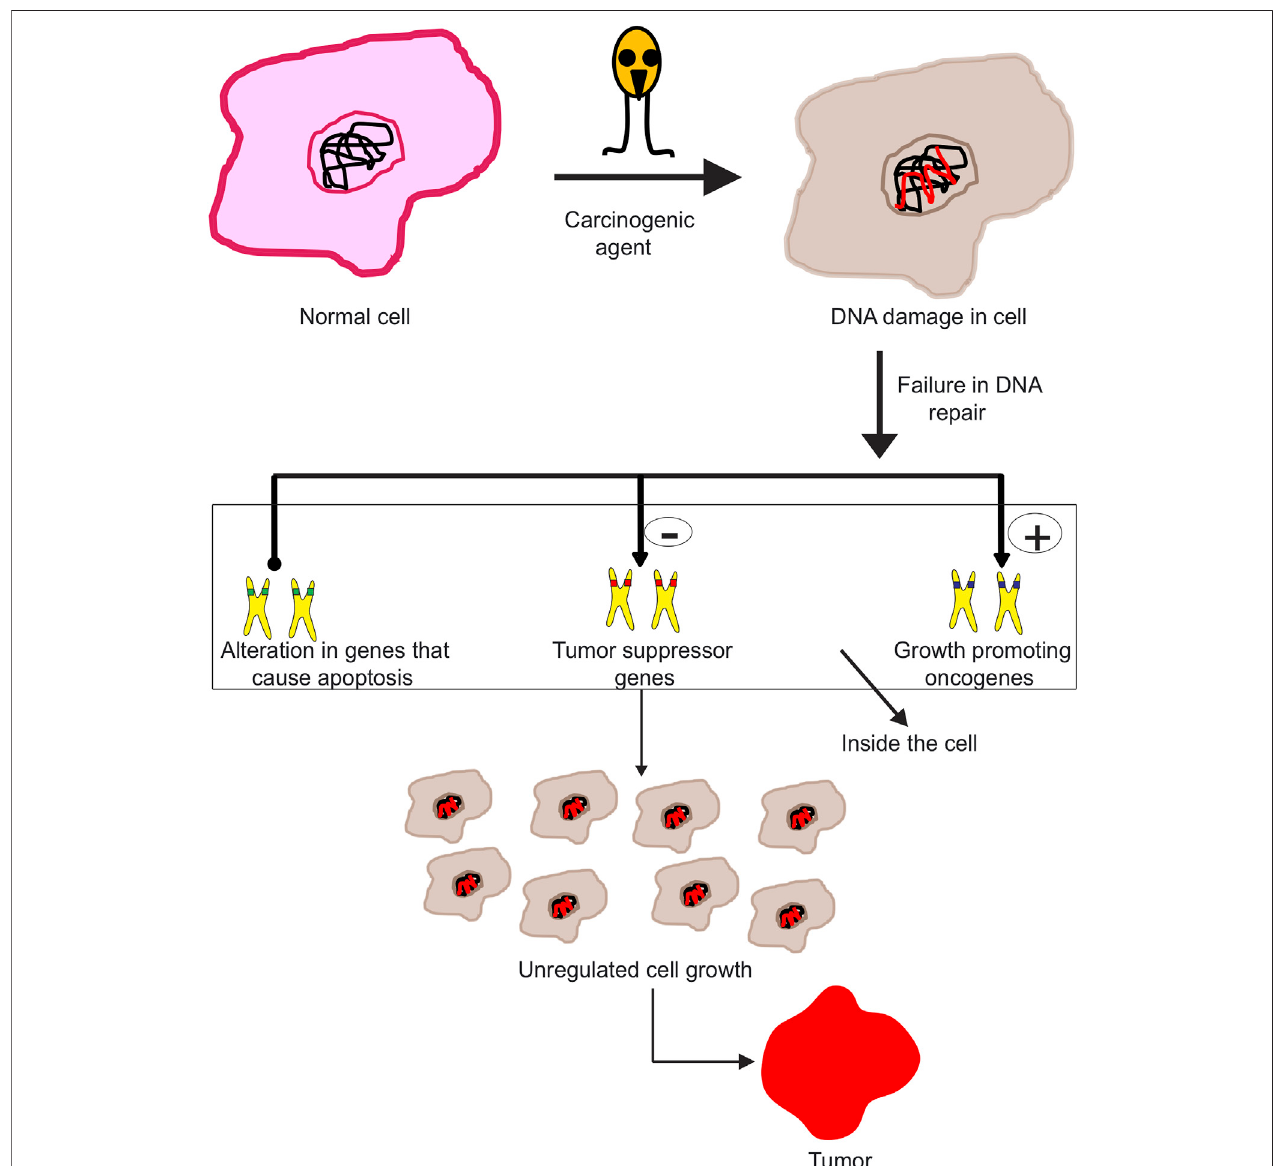
FIGURE 2 | Carbon dots bound to anticancer drug effectively target the tumor cells and deliver the drug molecule at the cell surface; interaction of the drug with tumor cell results in its death.